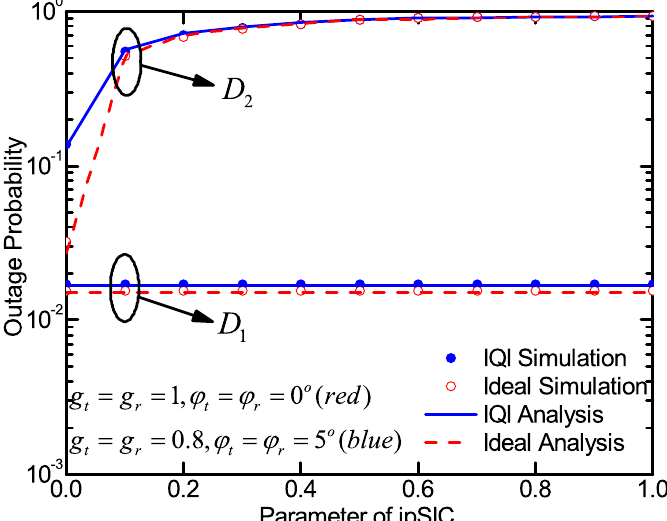
Figure 3. Outage probability versus the parameter of ipSIC for the system with IQI and ideal conditions. In Figure 4, we show the outage probabilities of D 1 and D 2 with ipSIC under the different levels of phase mismatch. The outage performances of D 1 and D 2 deteriorate with the increase of the value of phase mismatch. The greater the gap between the value of the phase mismatch and zero degrees, the greater the adverse effect of the phase mismatch on outage performance.